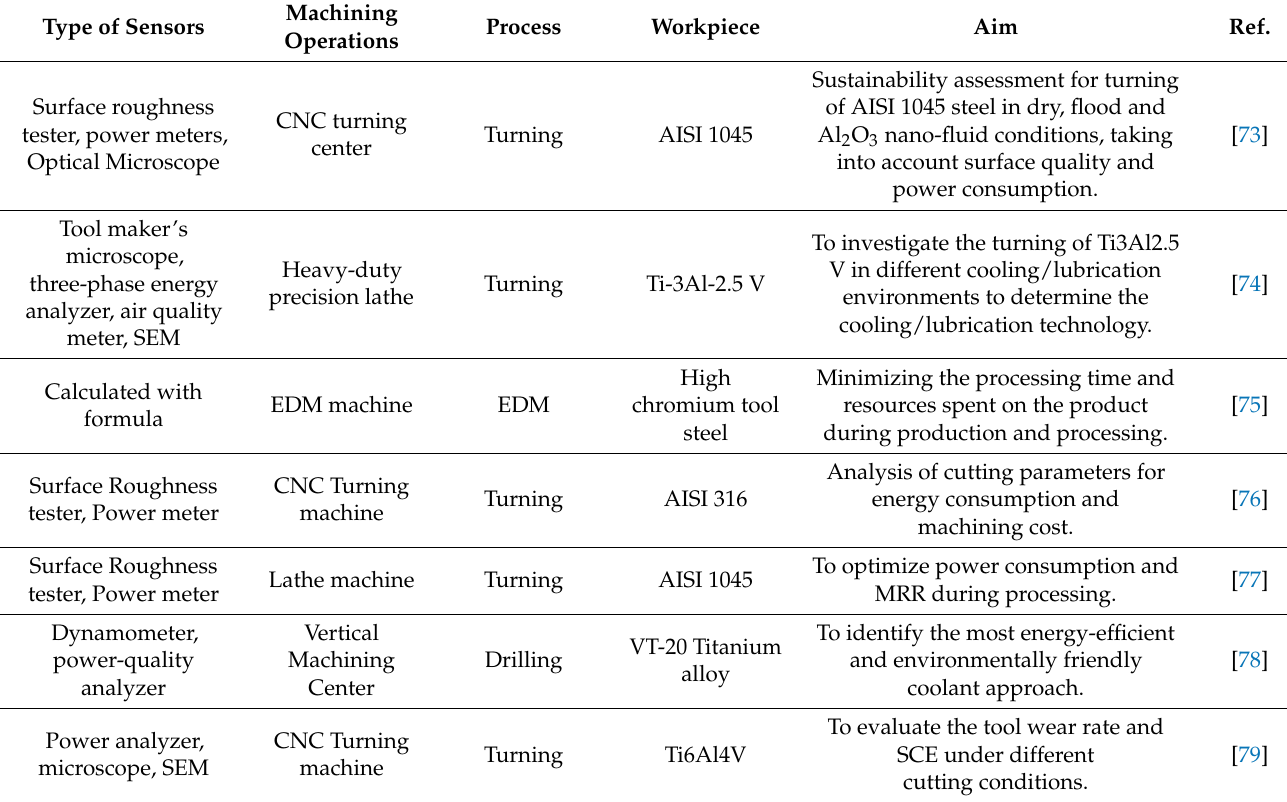
Table 4. Literature review of power and energy consumption studies on